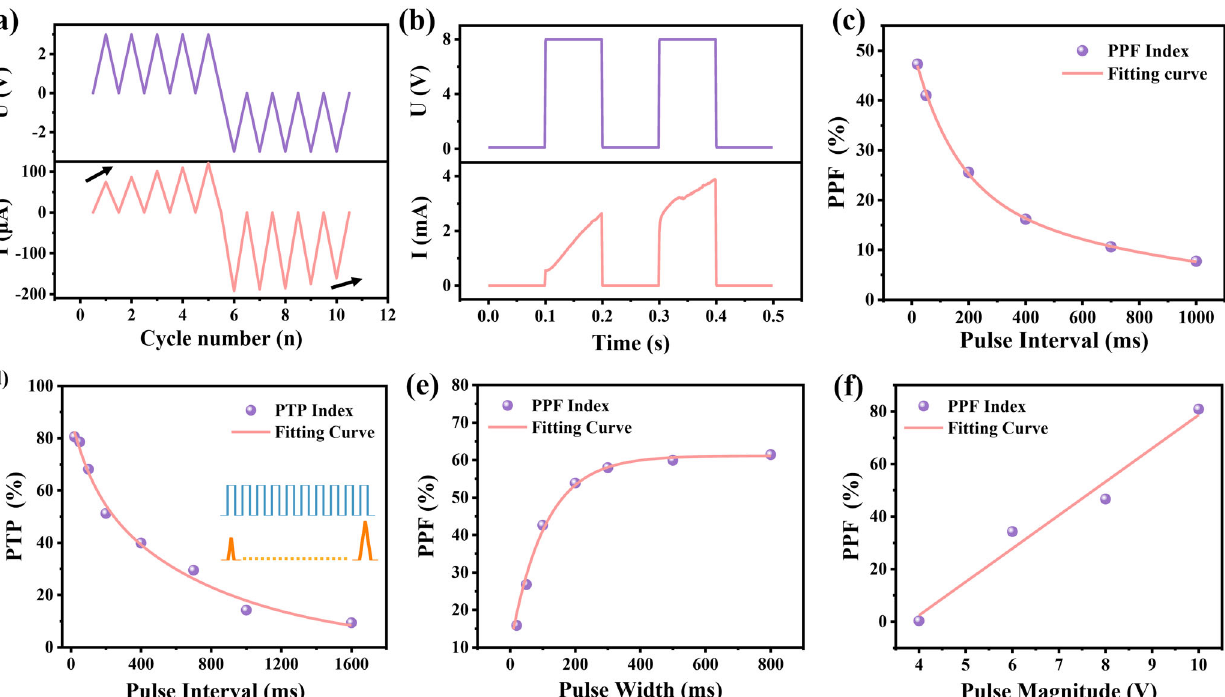
Fig. 4 Arti fi cial synaptic characteristics of the memristor. a Variations of voltage and current with respect to sweep cycles. b Emulations of PPF behaviors. The test parameters are pulse amplitude of 8 V, width of 100 ms, interval of 100 ms, and read voltage of 0.1 V. c The PPF indexes at different pulse interval, which varies from 20 to 1000 ms. d The PTP indexes versus pulse interval, which varies from 20 to 1600 ms. The PPF indexes versus pulse ( e ) width, and ( f ) magnitude, which varies from 10 to 800 ms, and from 4 to 10 V,